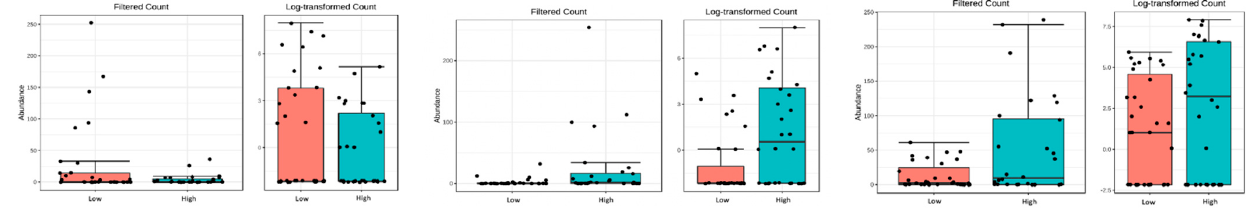
Figure 1. Bacterial taxa differing significantly in abundance when comparing the groups of individ- uals with high and low levels of biochemical biomarkers (FDR < 0.05): AST, HDL-cholesterol and insulin. Red boxes represent participants with lower levels, and blue boxes represent participants with higher levels of the specified biochemical